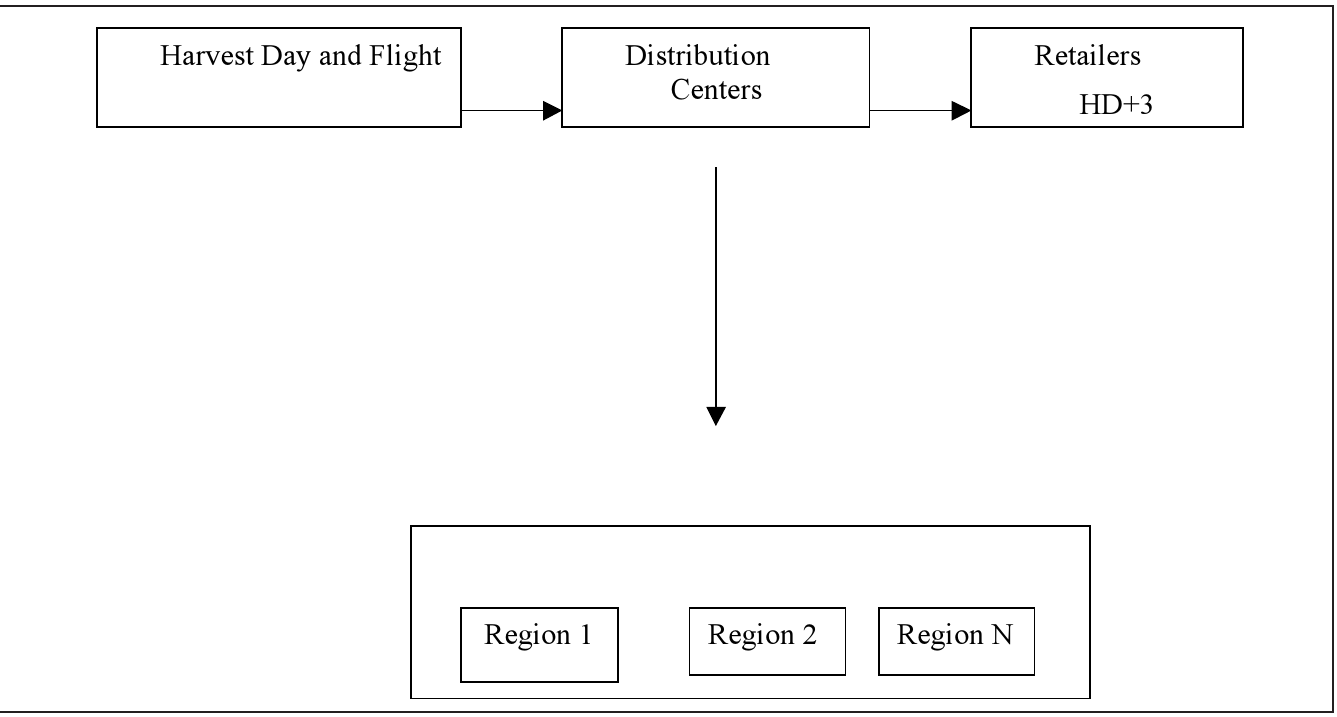
Figure 4. Dutch Distribution